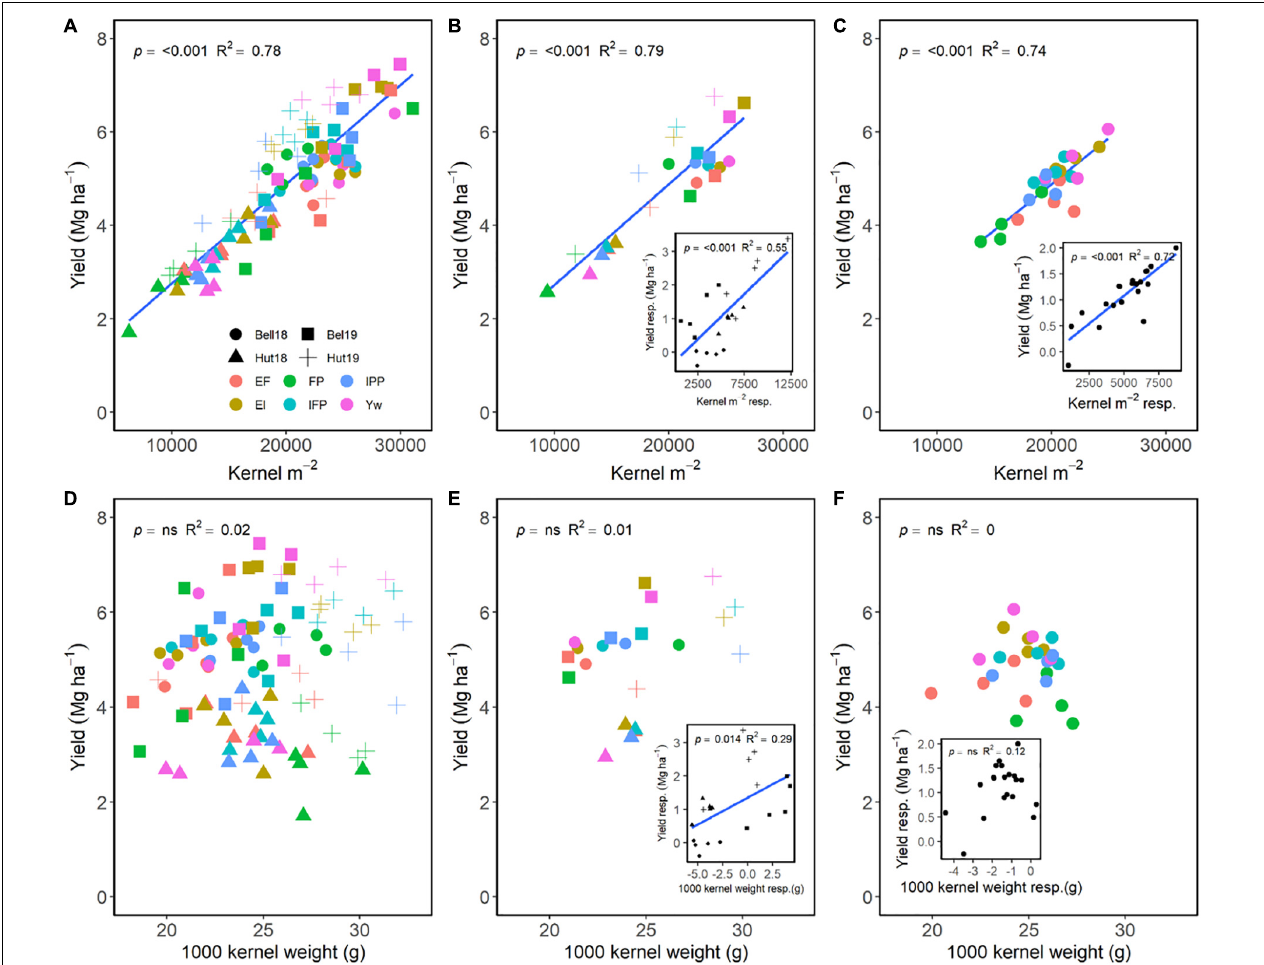
FIGURE 4 | Relationship between yield and kernels m − 2 (A–C) or 1,000 kernel weight (D–F) across environments, wheat genotypes, and management systems ( n = 96) (A,D) , on average, each management for each environment ( n = 24; 6 management practices × 4 environments) (B,E) , on each genotype for each environment ( n = 24; 6 management practices × 4 genotypes) (C,F) . Inset graphs are the relationships between the responses of the variables to each management practices (difference between each management practice from the FP) averaged across either genotype for each management practice ( n = 20) or management for each environment ( n = 20) (C,F)